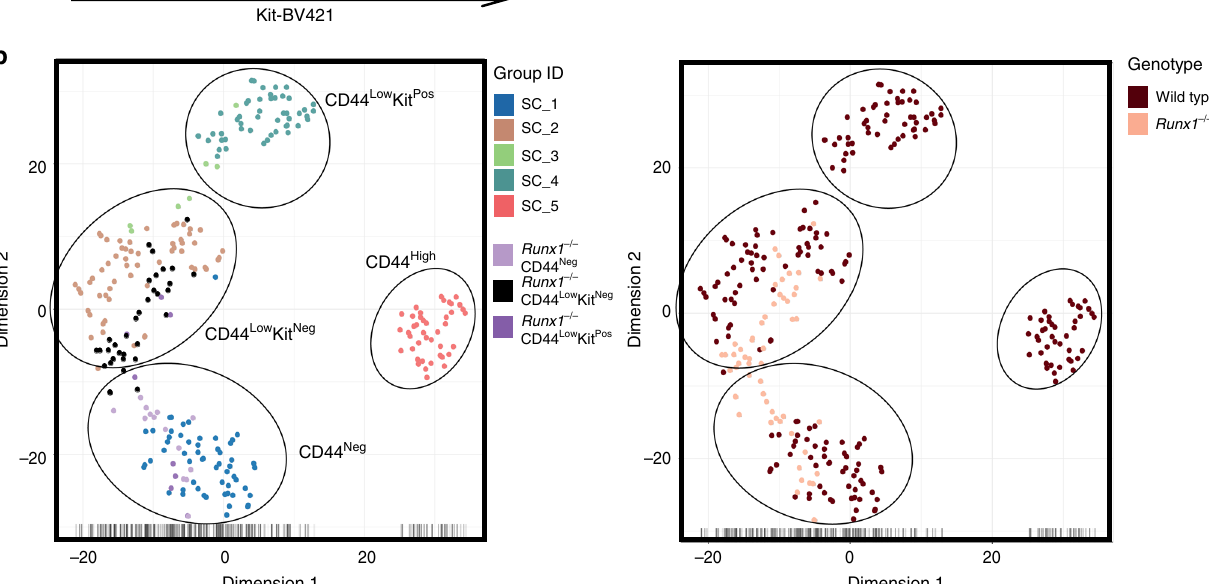
Fig. 7 Runx1 is required for the generation of CD44 Low Kit Pos and CD44 High cells. a FACS plots of VE-Cad and CD44 expression in the AGM region at E10.5 from Runx1 + / + (left) and Runx1 − / − (right) embryos. b tSNE plots from single-cell q-RT-PCR data shown in a . See also Supplementary Fig. 14 and Supplementary Data